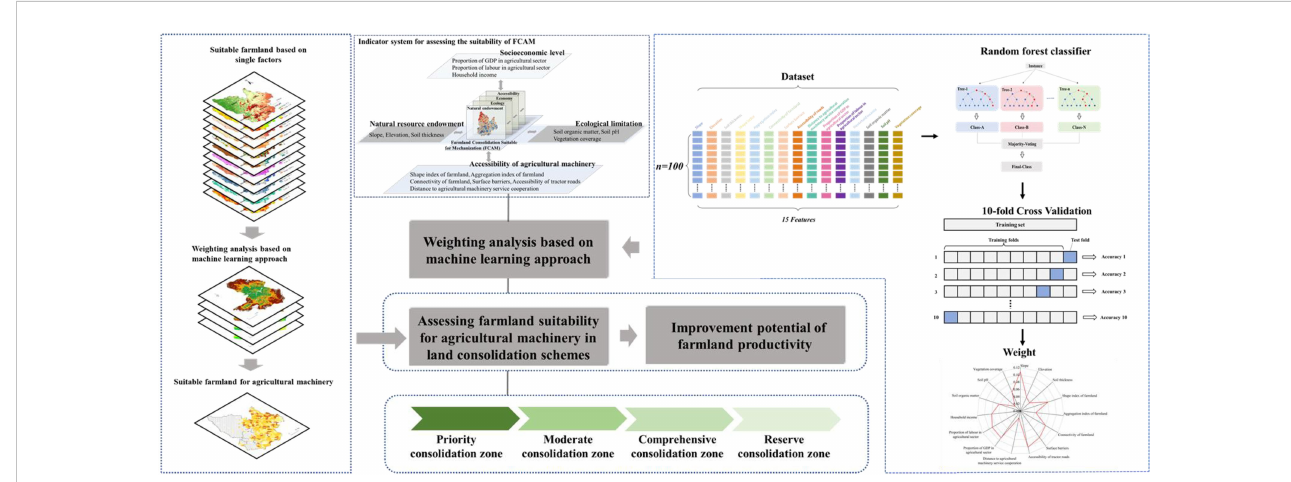
FIGURE 2 Methods for the assessment of the suitability of FCAM. FCAM, farmland consolidation suitable for agricultural